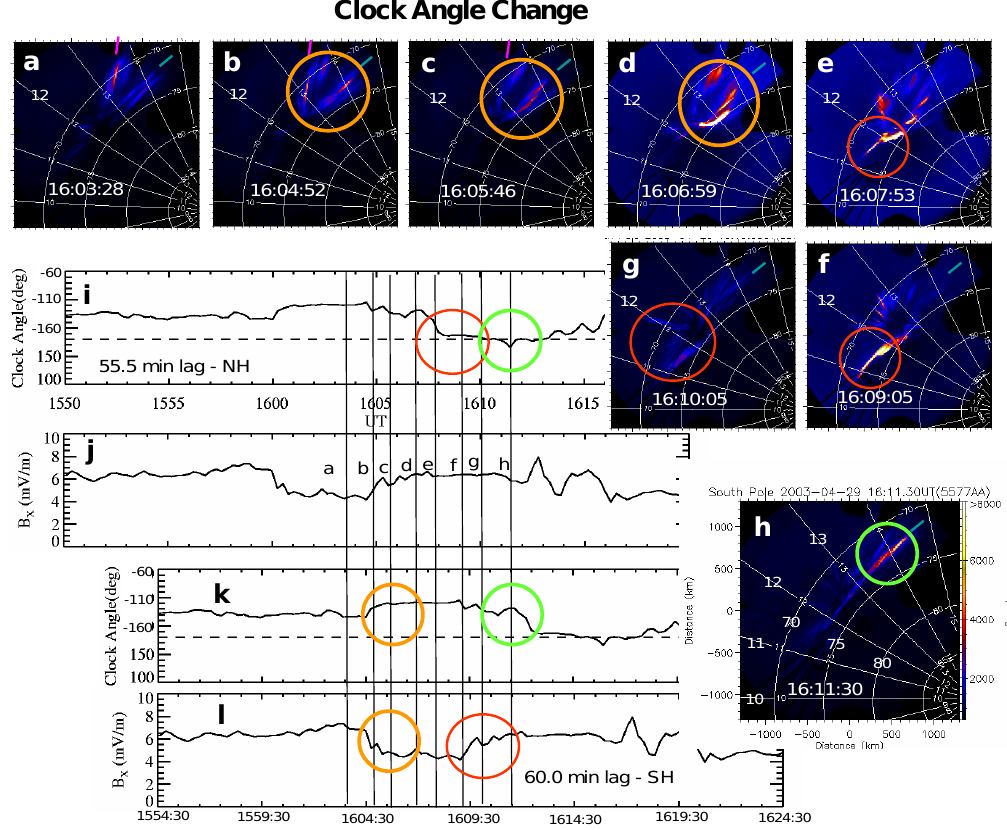
Fig. 11. Responses to clock angle changes. (a–h) 557.7nm all-sky images at selected times noted by the vertical lines in the data trace plots (i–l) . The clock angle and B X plots are shown using the measured lag for the northern hemisphere and the deduced lag for the southern hemisphere. To simplify references to the simulations we let clock angles assume negative values for θ> 180 ◦ . Circles highlight changes in the IMF and apparent optical